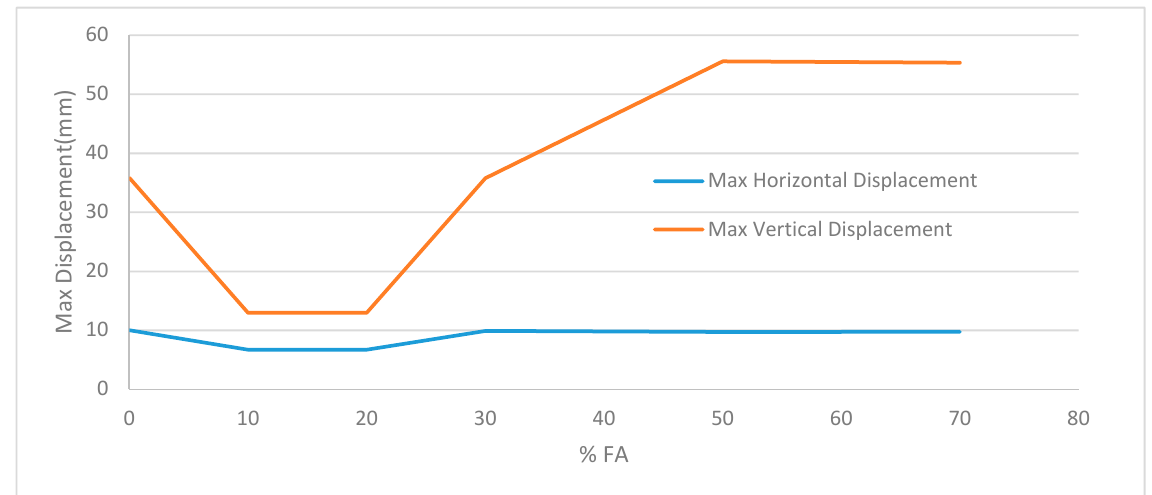
Figure 24. Comparison of vertical and horizontal displacements at node 20, element 1126 among all GPC mixtures with 0%, 10%, 20%, 30%, 50%, 70% FA.